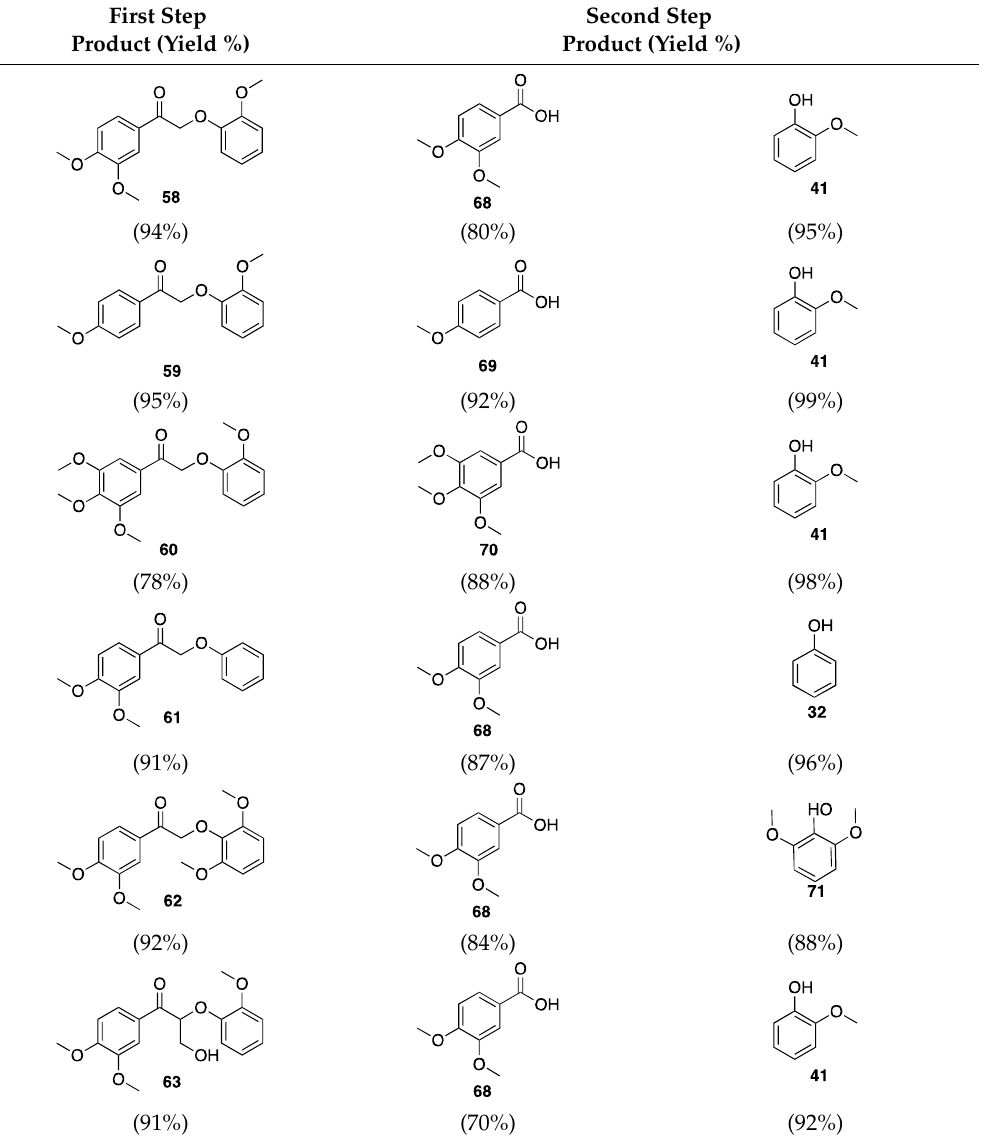
Table 2. Substrate scope.